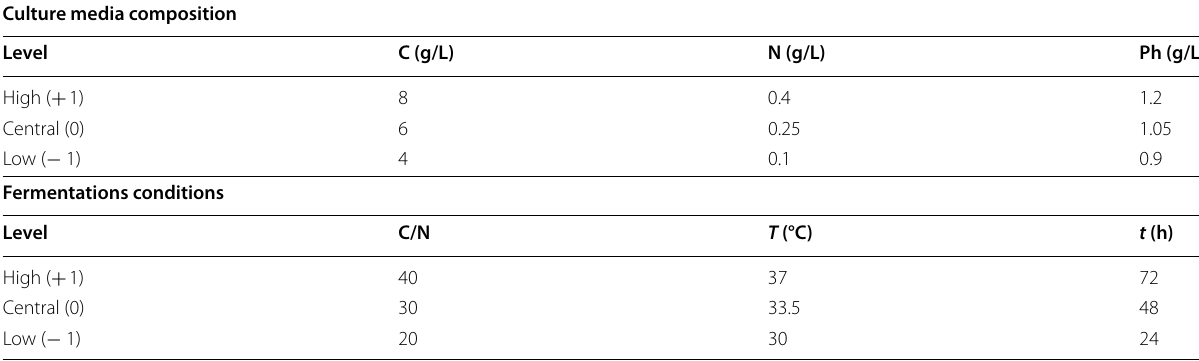
Table 1 Independent variables with their respective coded values and levels used in the Box–Behnken design